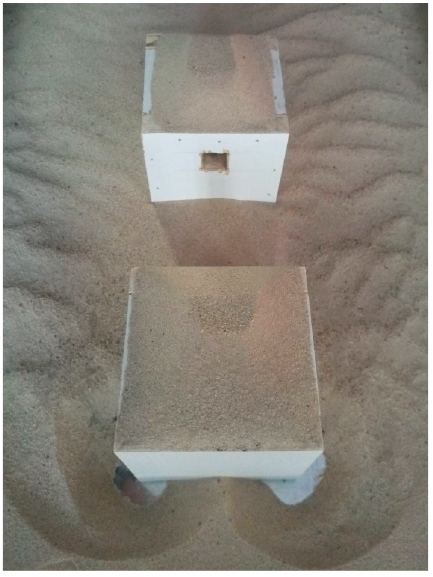
Figure 9: Snow distribution after